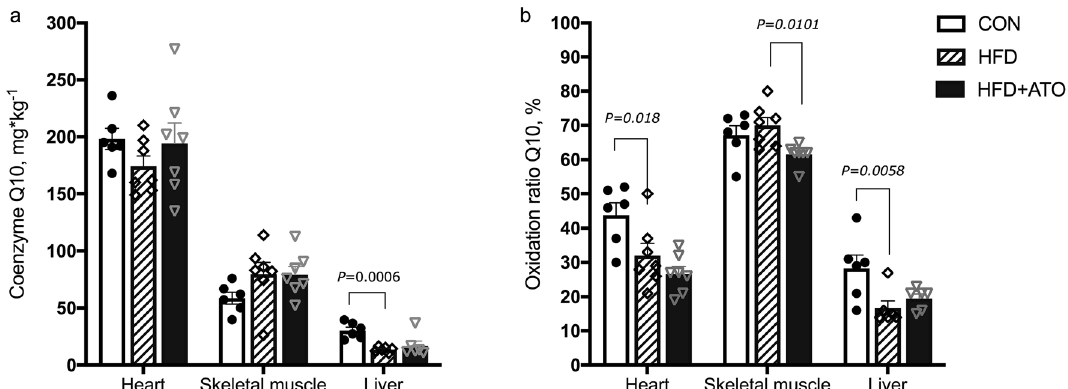
Figure 3. Total concentration and oxidation rate (%) of Coenzyme Q10 (Q10) in heart muscle, skeletal muscle and liver in control (CON), obese (HFD) and obese atorvastatin treated Göttingen Minipigs (HFD + ATO). Q10 oxidation rate was calculated as the percentage of total Q10 that was oxidized. ( a ) Total Q10 concentration in heart muscle, skeletal muscle and liver from the Göttingen Minipigs. ( b ) Oxidation rate of Q10 in heart muscle, skeletal muscle and liver from the Göttingen Minipigs. Bars and error bars denote means ± SEM, n = 6–7 in each